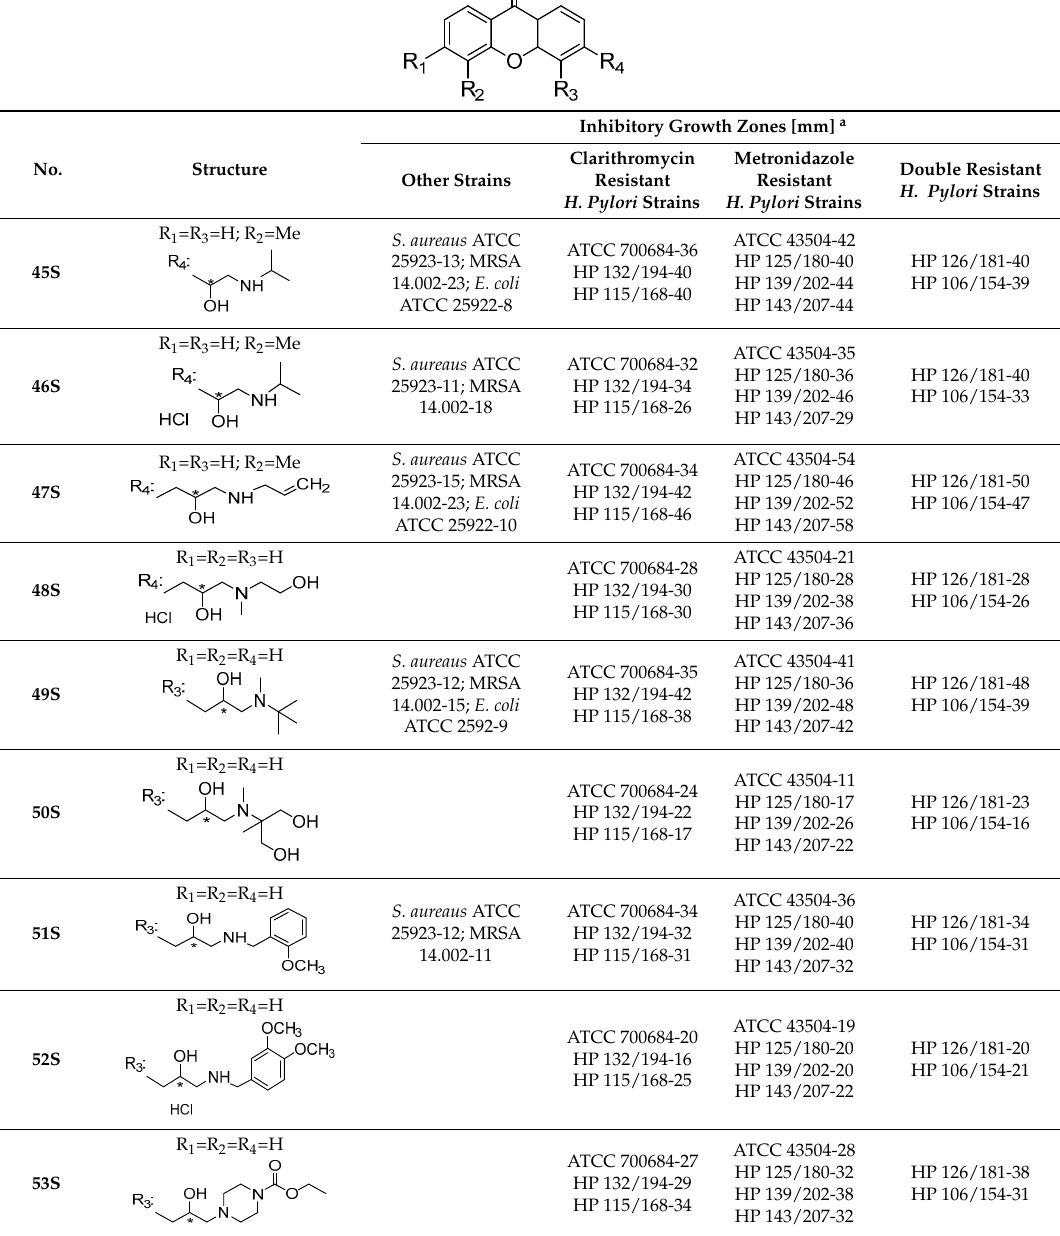
Table 11. Anti-bacterial activity of xanthone derivatives with 2-hydro-3-amino and piperazine groups.